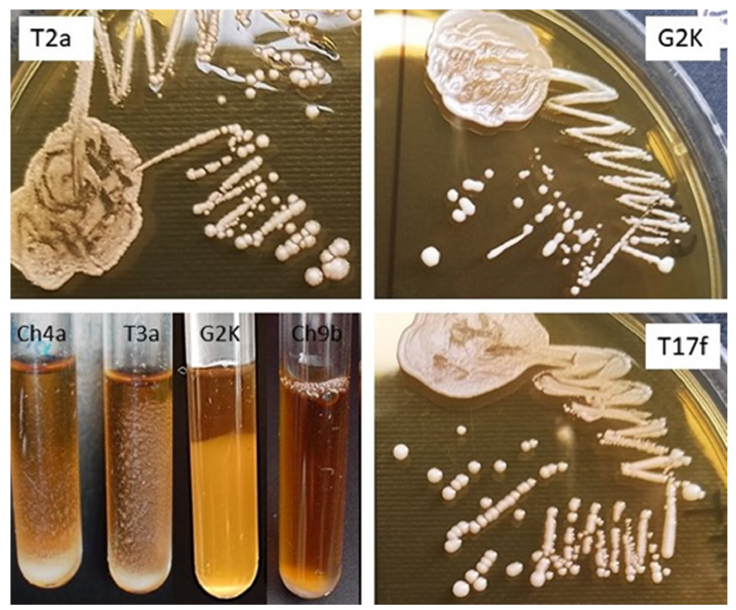
Figure 2. Phenotypes of selected L. salivarius strains on MRS agar (strains T2a, G2K, T17f) and MRS broth (strains Ch4a, T3a, G2K, Ch9b).